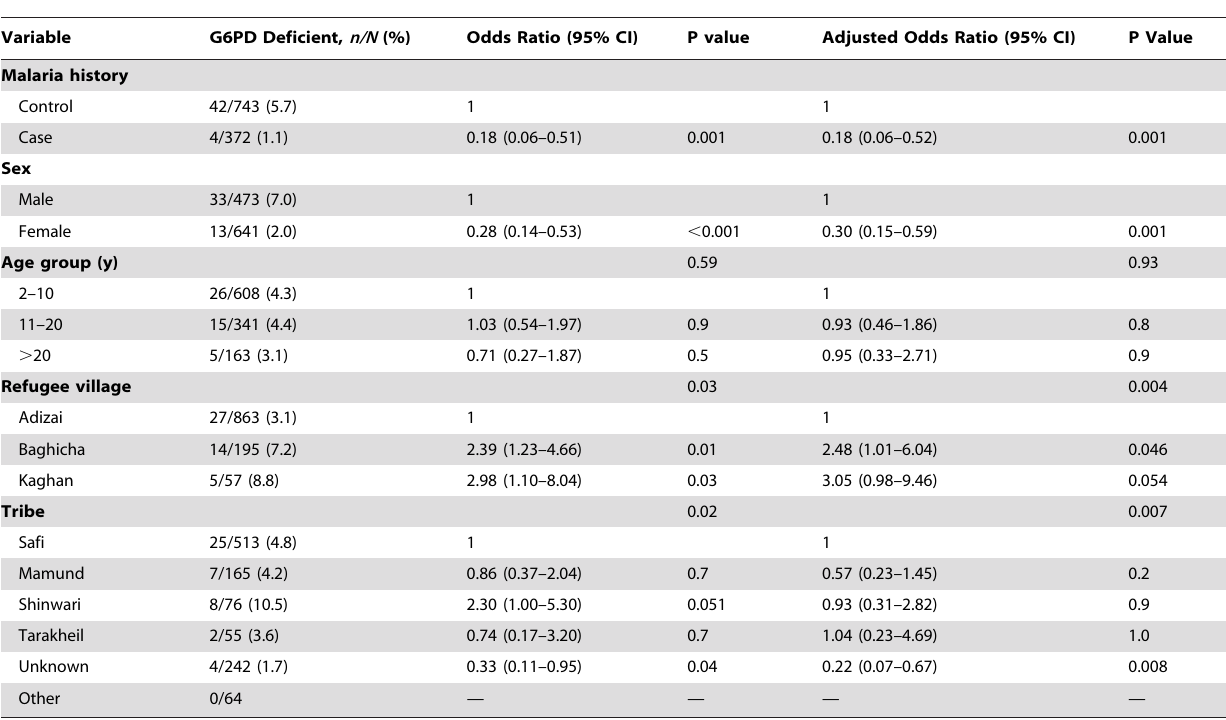
Table 2. Effect of malaria, sex, age group, village, and tribe on frequency of phenotypic G6PD.